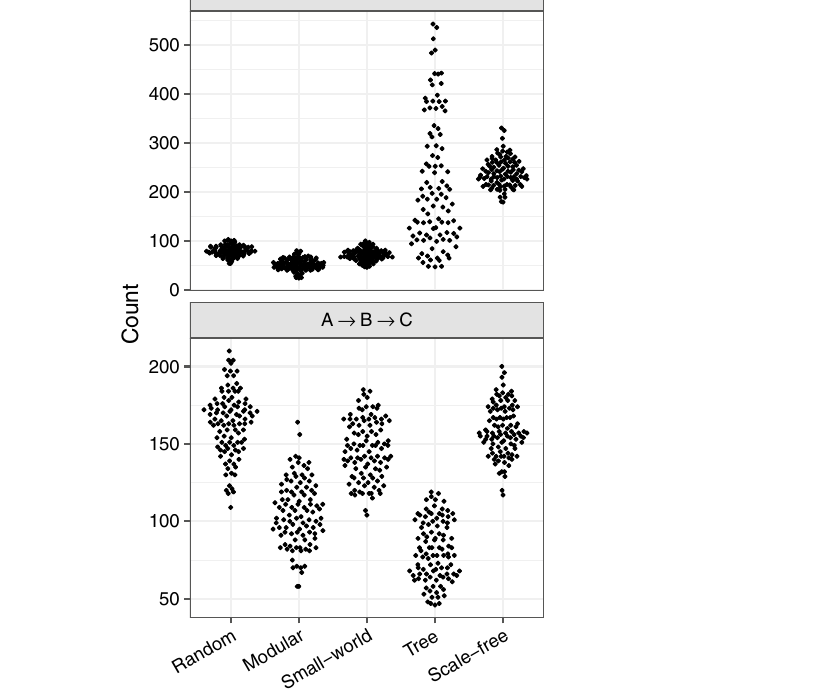
Figure 5. Triad counts for two of the possible configurations of three-node directed subgraphs in each random metapopulation network that correspond to the aforementioned archetypal networks. Points are grouped according to network structure ensemble (see Methods and top row of Fig. 4). As in Fig. 4, we see that for the “in-star” triad ( A → C ← B ), random, modular, and small-world networks tend to have similar values,